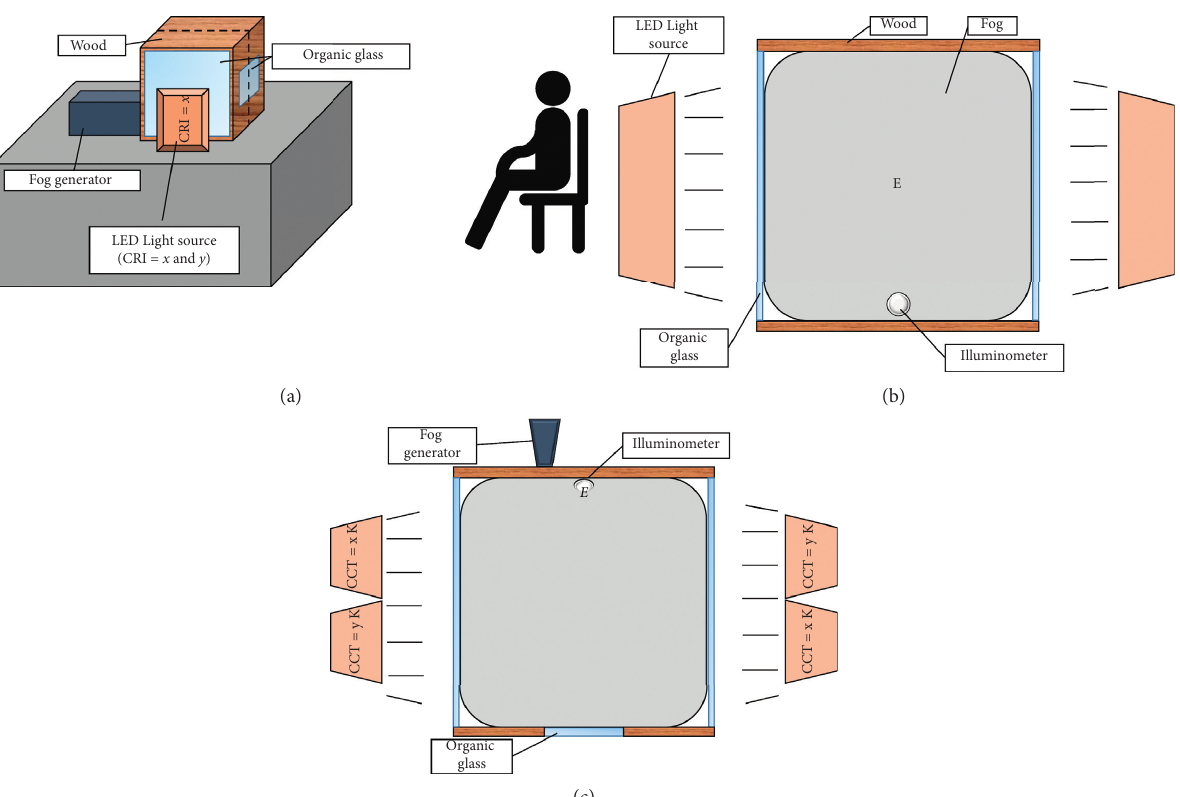
Figure 11: Schematic diagram of experimental setup. (a) Overview of experimental facility. (b) The section of the front view. (c) The section of top view.